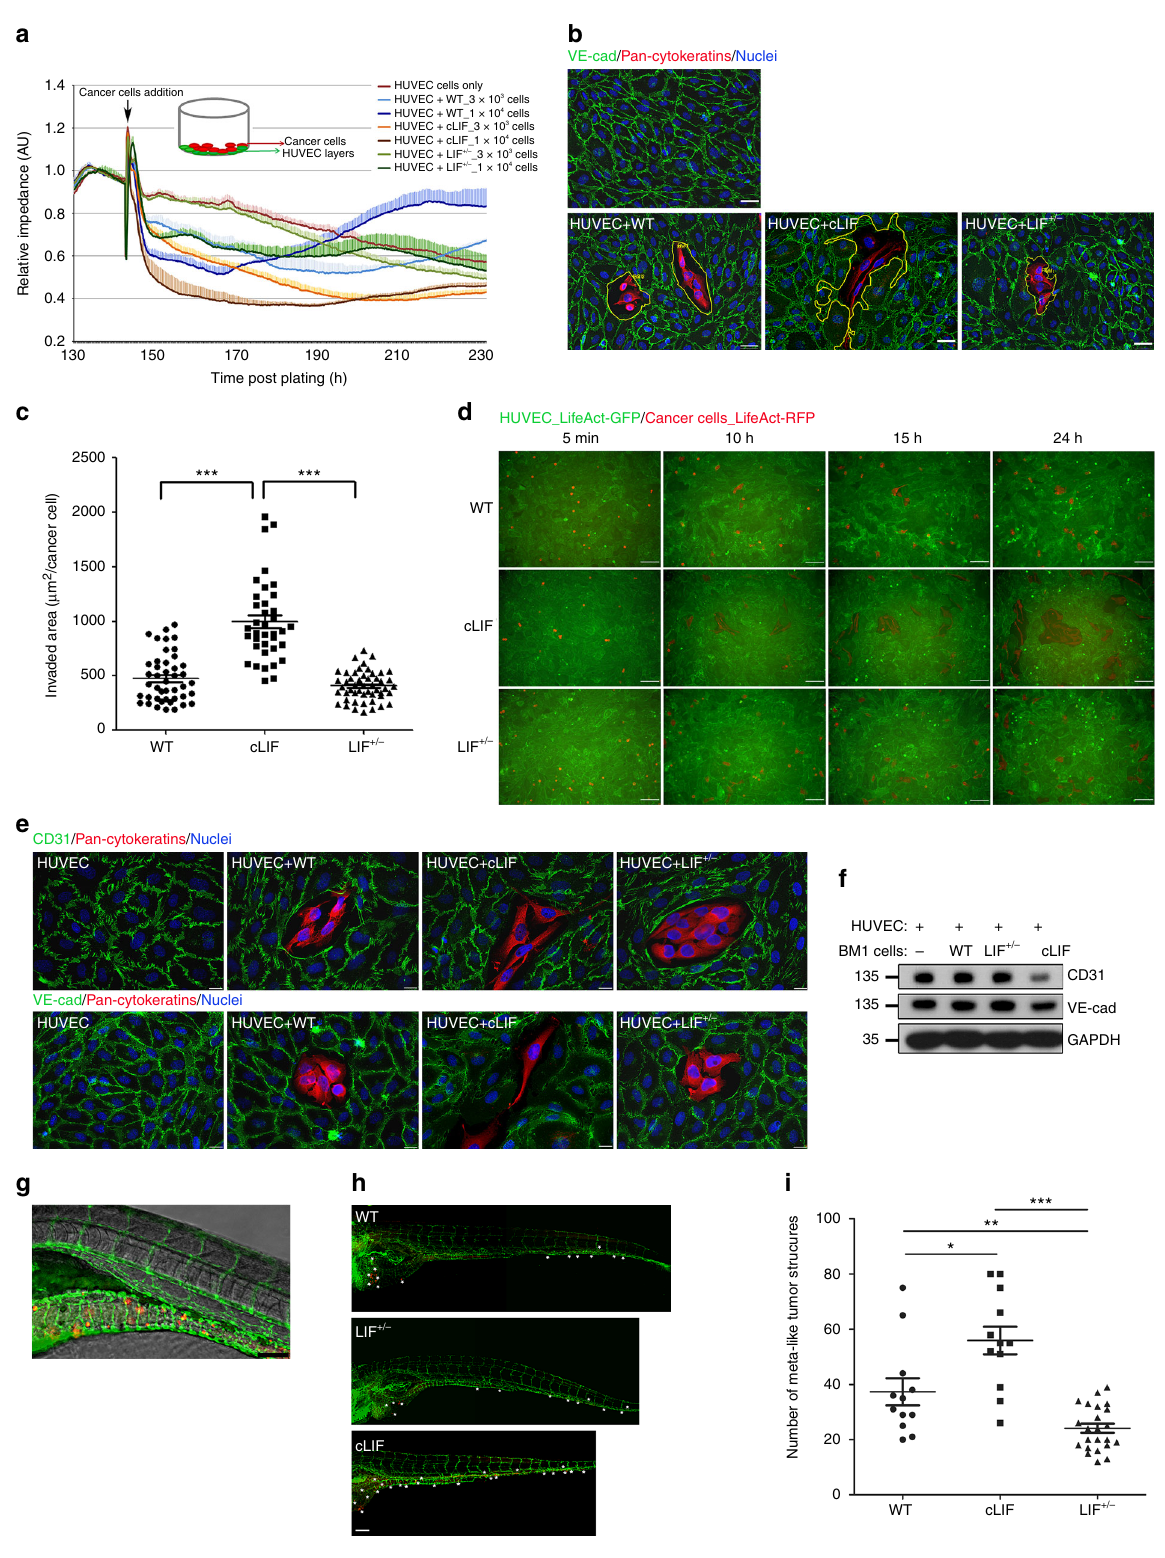
whereas hot spots were primarily detected at the belly of WT and LIF + / − cells (Fig. 5c). Notably, damaged HUVEC areas were detected at the invasive front with high Talin-GFP expression (Fig. 5c, white arrow). To evaluate whether cytoplasmic LIF is correlated with focal adhesion molecules in human tumors, we examined the expression patterns of LIF, p-PXN (Y118), and